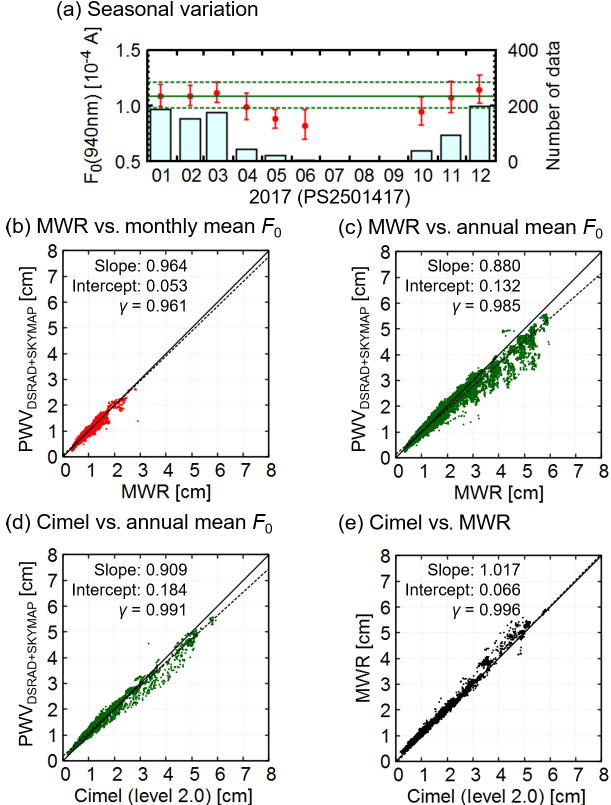
Figure 17. Application of our methods to observational data from Chiba in 2017. (a) Seasonal variation in the calibration constant of the water vapor channel (red circles and error bars are monthly means and standard deviations, respectively; green solid and dotted lines are annual means and standard deviations, respectively; boxes indicate the number of data points). (b, c) Comparison of PWV be- tween the MWR and the sky radiometer with (b) the monthly mean F 0 and (c) the annual mean F 0 . (d) Comparison of PWV between the Cimel level 2.0 data and the sky radiometer with the annual mean F 0 . (e) Comparison of PWV between the Cimel level 2.0 data and the